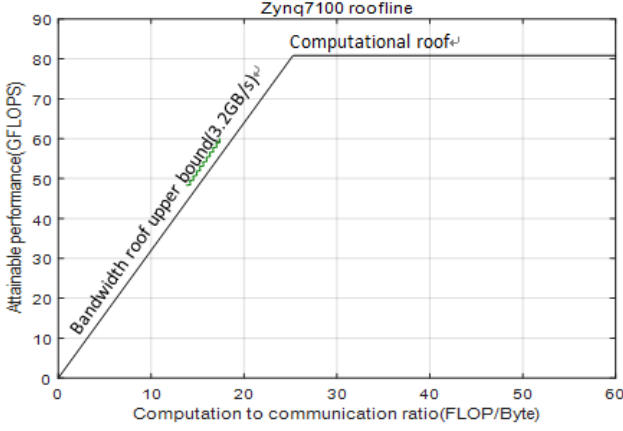
Figure 6. The roofline model of ZYNQ 7100.